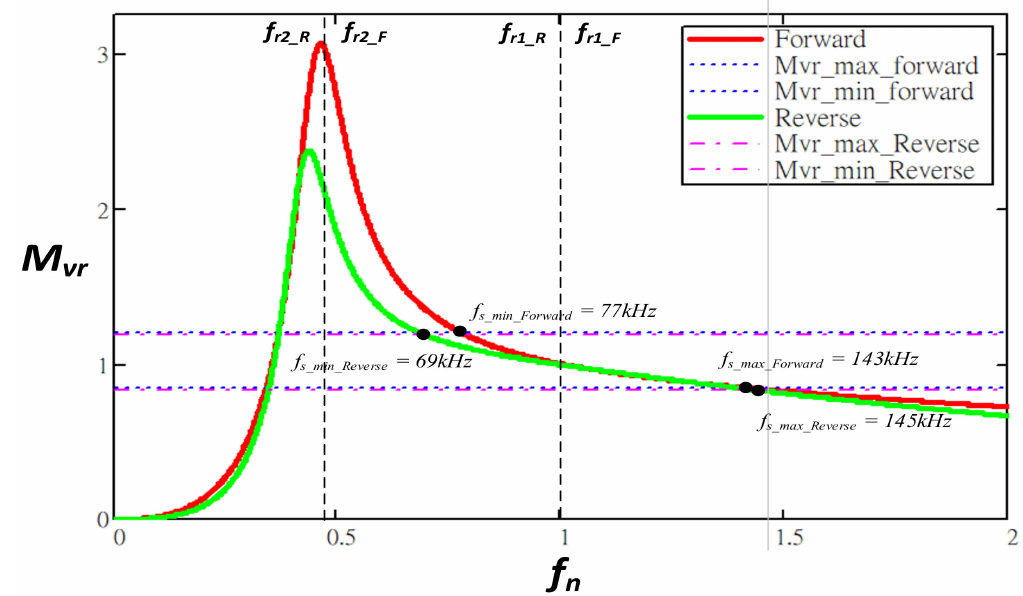
Figure 12. The voltage gain curves operating in the forward and reverse charging